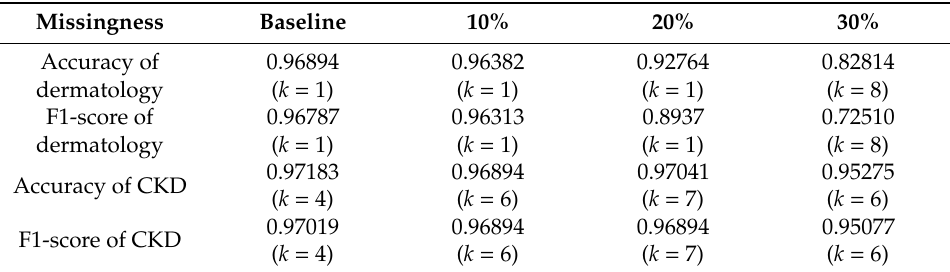
Table 3. Best results of user-based collaborative filtering (CF) model for each dataset.